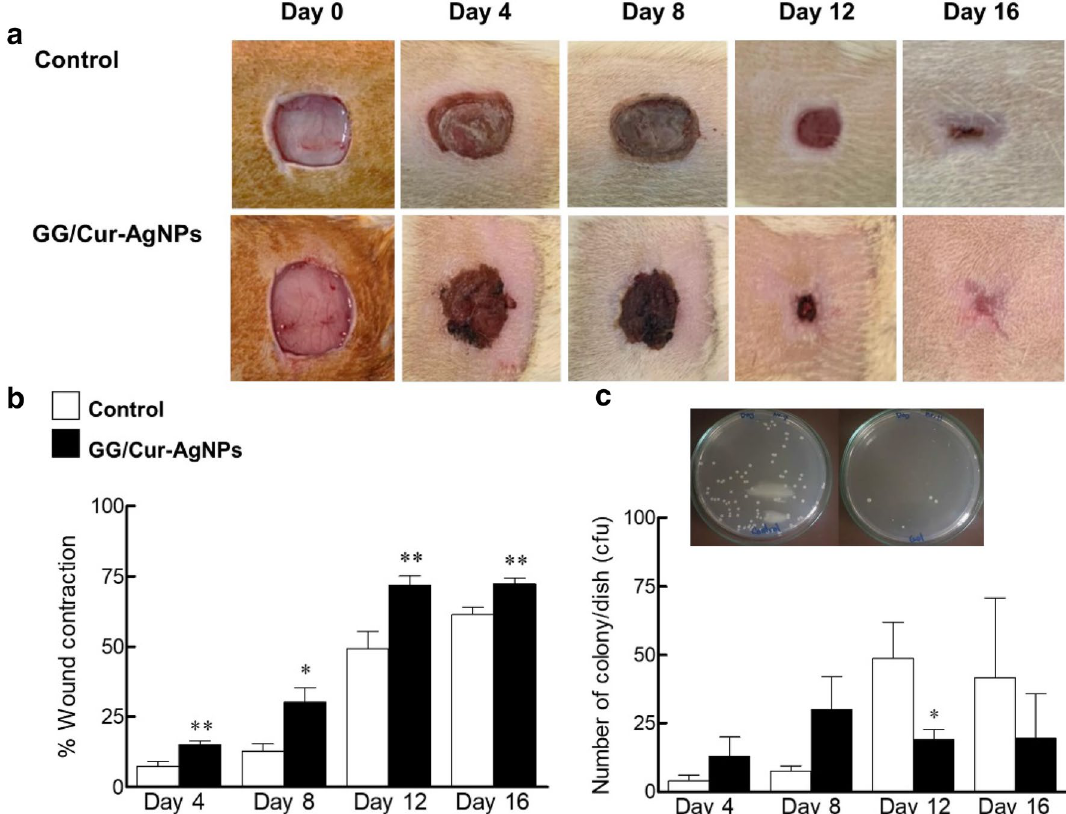
Figure 5. Effects of GG/Cur-AgNPs on wound healing and bacterial contamination in rats. ( a ) Time- dependent evolution of rat skin wound closure observed for treatment with commercial antibacterial gels (control) and with the GG/Cur-AgNPs hydrogel composite. ( b ) Percentage wound area contraction calculated on days 4, 8, 12, and 16 post-wound incision for treatment with commercial antibacterial gel and GG/Cur- AgNPs hydrogel composite. c, Comparison of bacterial colony count (CFU) at the wound site for treatment with commercial antibacterial gel and the GG/Cur-AgNPs hydrogel composite. Data were expressed as mean ± SEM ( n = 3–4/time point). * P < 0.05 and ** P < 0.01 compared to control on day of